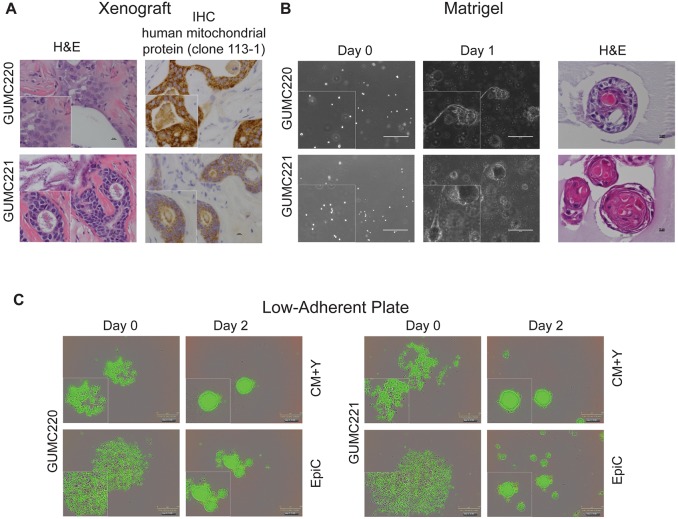
GUMC220 and GUMC221
MEC
primary cells demonstrated xenograft growth in vivo and 3D growth in vitro. (A) Representative images of xenograft histology: H&E (left), IHC for human mitochondrial protein (clone 113-1) (right). Images were taken at 40× magnification. Scale bars: 10 μm. Bottom left insets show magnified images; 220 xenografts, n=3; 221 xenografts, n=2. (B) Representative phase-contrast images from in vitro 3D Matrigel culture: single cell suspensions at day 0 (left), spheroid formation at day 7 (center), and representative H&E images of spheres (right). Images were taken at 10× magnification. Scale bars: 400 μm. Bottom left insets in day 0 and day 1 panels show magnified images. n=3. (C) Representative green fluorescence images from in vitro 3D low-adherent plate culture: single cell suspensions in CM+Y and EpiC at day 0 (left), spheroid formation in CM+Y and EpiC at day 2 (right). Images were taken at 10× magnification. Scale bars: 300 μm. Bottom left panels show magnified images. Each experiment included three cell/condition technical replicates and each experiment was completed three times.